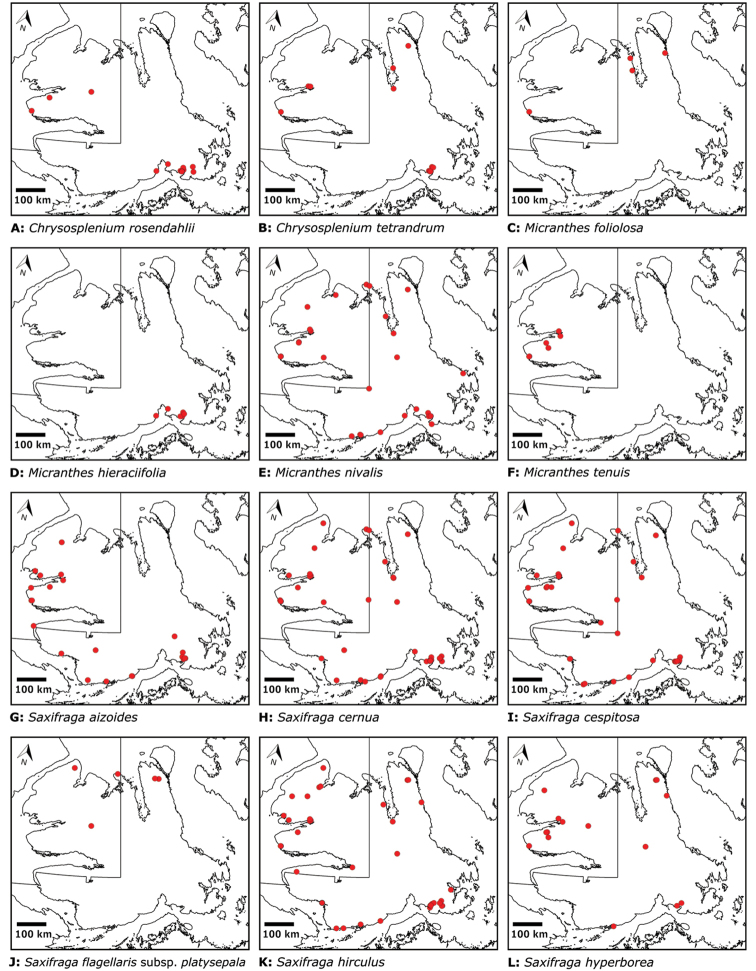
Species distribution maps. Saxifragaceae: AChrysosplenium
rosendahliiBChrysosplenium
tetrandrumCMicranthes
foliolosaDMicranthes
hieraciifoliaEMicranthes
nivalisFMicranthes
tenuisGSaxifraga
aizoidesHSaxifraga
cernuaISaxifraga
cespitosaJSaxifraga
flagellaris
subsp.
platysepalaKSaxifraga
hirculusLSaxifraga
hyperborea.